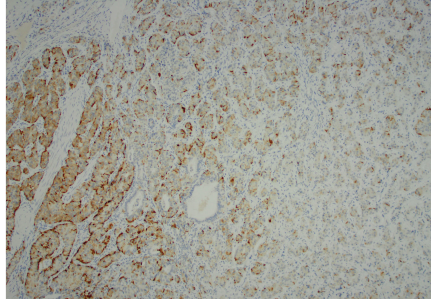
Figure 6: Neuroendocrine component (carcinoid) stained positive for